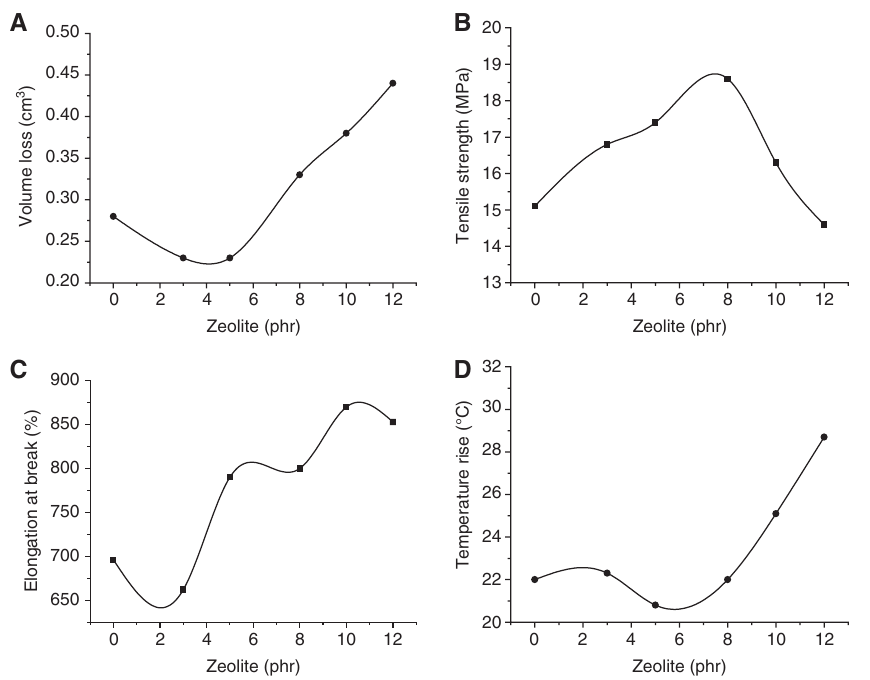
Figure 4 Mechanical properties of zeolite/rubber composites with different amounts of modified zeolite. (A) Abrasion property of composites; (B) tensile strength of composites; (C) elongation at break of composites; (D) dynamic heat generation.